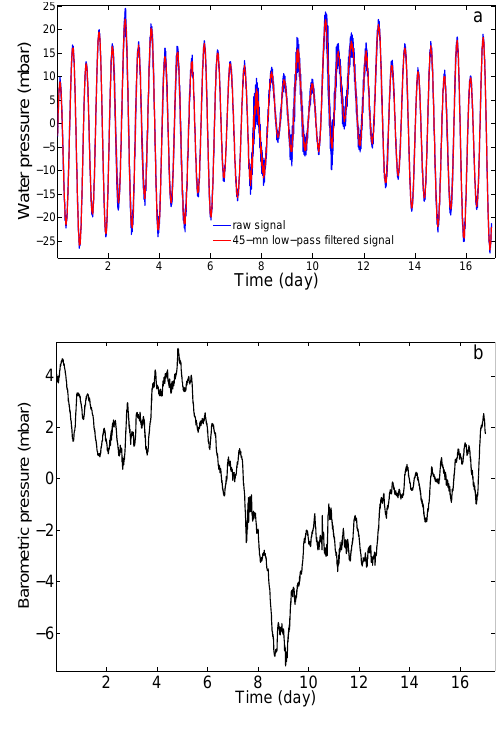
Figure 8. 17daysofexternalforcingatMOK,june2010. (a)Sealevel at Trizonia island: (blue) raw data; (red) low-pass filtered signal at 45 minutes period; (b) Barometric pressure fluc- tuation at MOK. Such signals are the forcing signals used for calibrating the gauges and for providing the calibration coefficients given by Table 1.